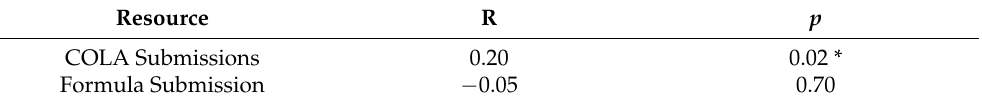
Table 9. Relationship between the Volume of Resources Used and Resubmission